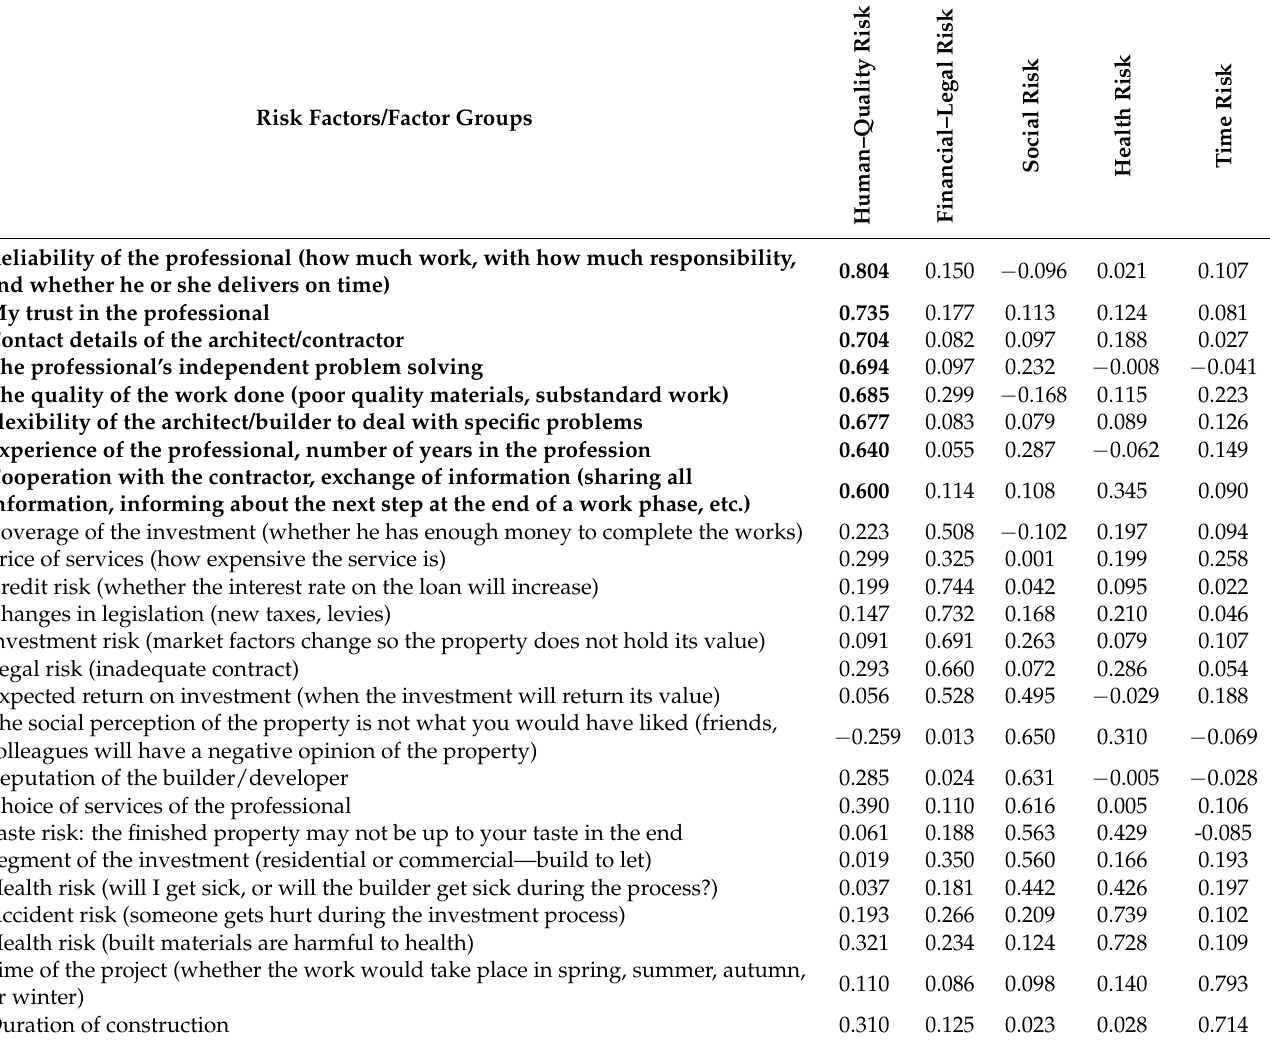
Table 6. Investor risk factor structure for the five